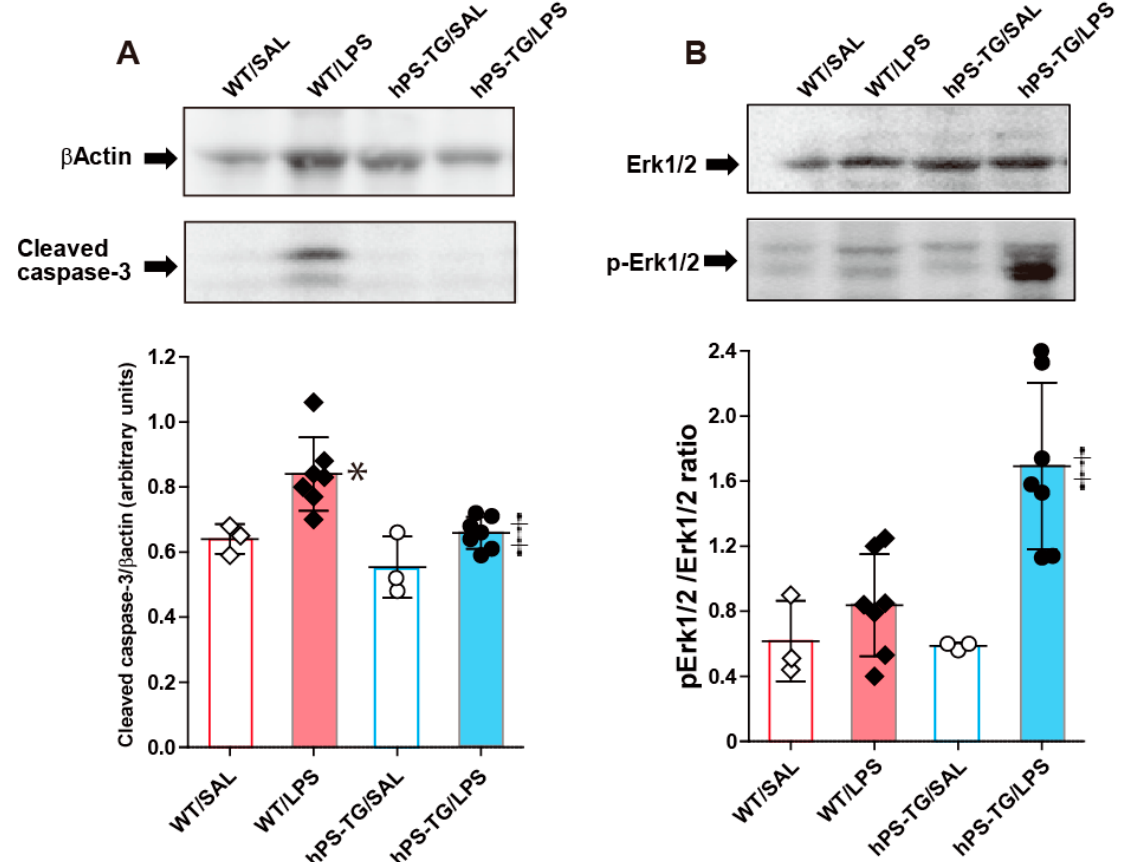
Figure 7. Decreased cleavage of caspase-3 and increased activation of Erk1/2 in mice overexpressing hPS. Mice were allocated in four groups including wild-type mice treated with saline (WT/SAL, n = 3) or LPS (WT/LPS, n = 7), and human PS transgenic (TG) mice treated with saline (hPS TG/SAL, n = 3) or LPS (hPS TG/LPS, n = 7). The presence of cleaved caspase-3 ( A ) and p-Erk1/2 ( B ) in lung tissue was evaluated by Western blotting. Quantification ImageJ WT/SAL; ‡ p < 0.05: hPS-TG/LPS vs WT/LPS. p-Erk1/2, phosphorylated-Erk1/2.